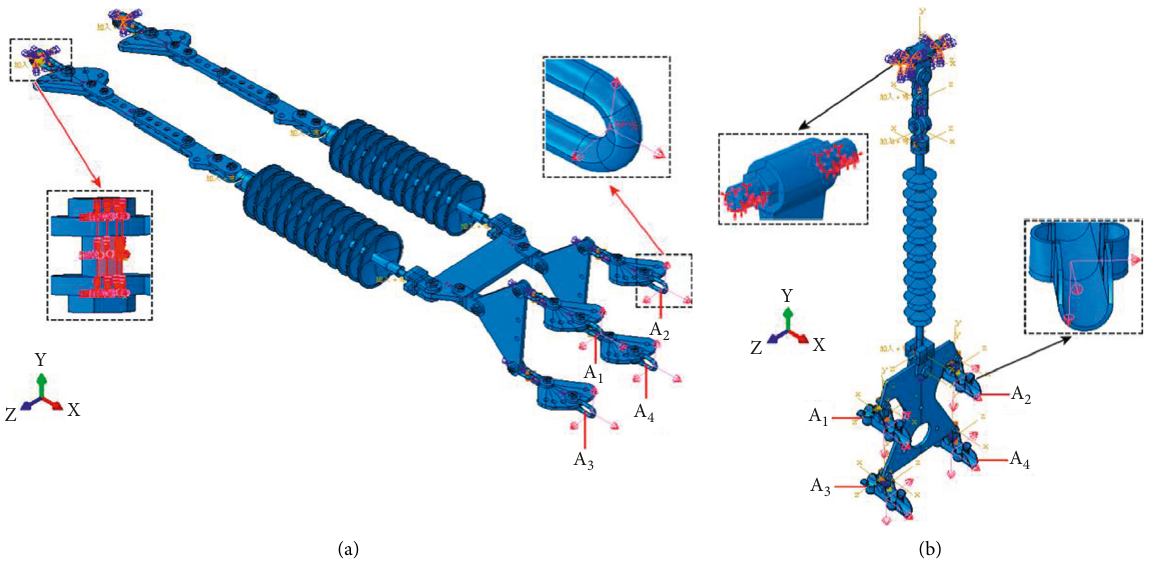
Figure 24: Boundary conditions and loads: (a) Tension string; (b) Suspension